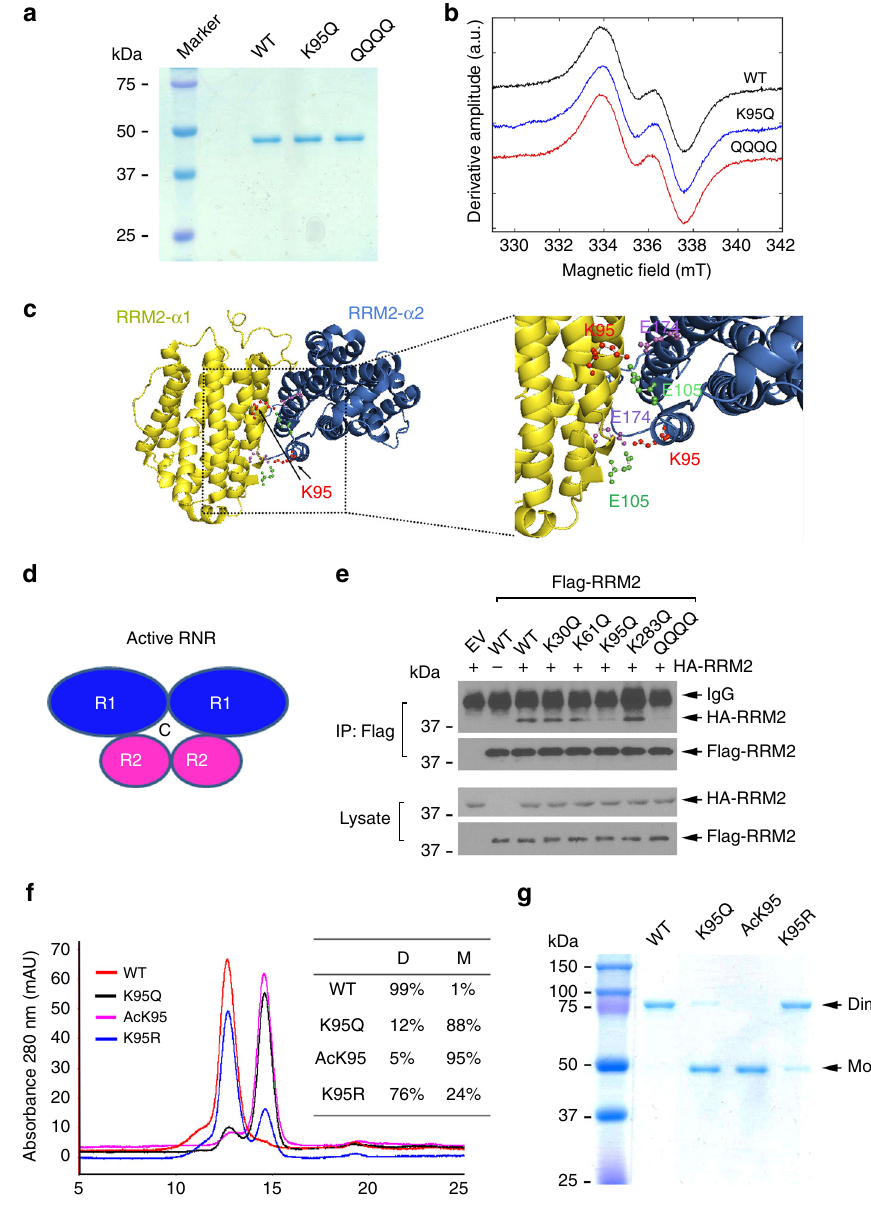
Fig. 2 RRM2 acetylation at K95 disrupts its homodimerization. a Recombinant His-tagged WT, K95Q, and QQQQ RRM2 proteins were puri fi ed from E. Coli . b Tyrosyl radical concentrations were measured by EPR spectroscopy: EPR spectra of WT, K95Q, and QQQQ RRM2 proteins. c K95 location within RRM2 structure (left panel). The RRM2 homodimer structure (PDB ID: 3OLJ) is shown, and K95 is predicted to form a salt bridge with E105 and E174 (right panel). d Schematic of active RNR complex. e H1299 cells were co-transfected with HA-RRM2 and Flag-tagged acetyl-mimetic RRM2 mutants, followed by co-IP using a Flag antibody. HA-RRM2 and Flag-RRM2 were analyzed by western blot using anti-HA or anti-Flag antibody, respectively. f Dimerization of recombinant WT, K95Q, AcK95, and K95R RRM2 proteins was analyzed by gel fi ltration chromatography. g SDS-PAGE analysis of recombinant WT, K95Q, AcK95, and K95R RRM2 proteins after cross-linking with 2 mM